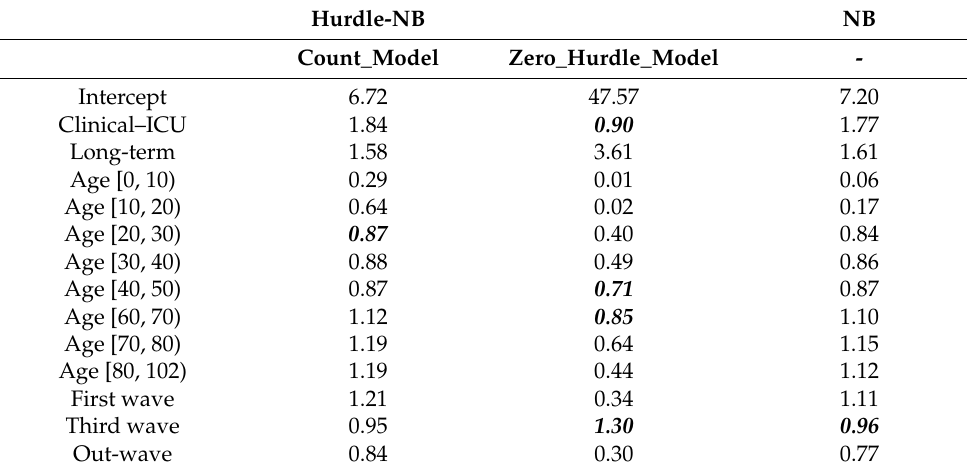
Table 6. Estimates of coefficients: exponential (coef). Hurdle-NB